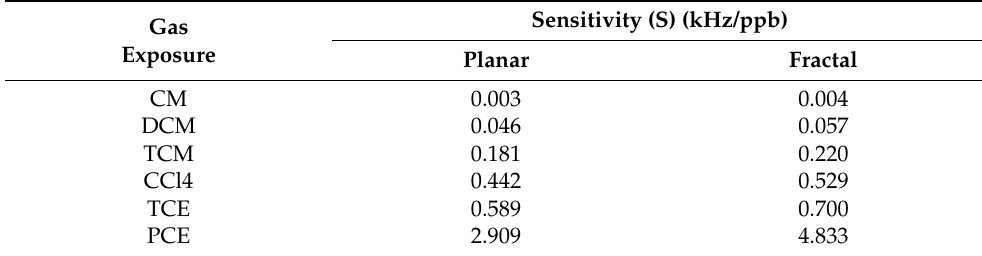
Figure 8. Reflection |S11| parameter of the 1 µ m PIB − coated planar and fractal electrode-based FBAR for 0 and 1000 ppm PCE gas exposure. Table 4. Sensitivity to different gas exposure.